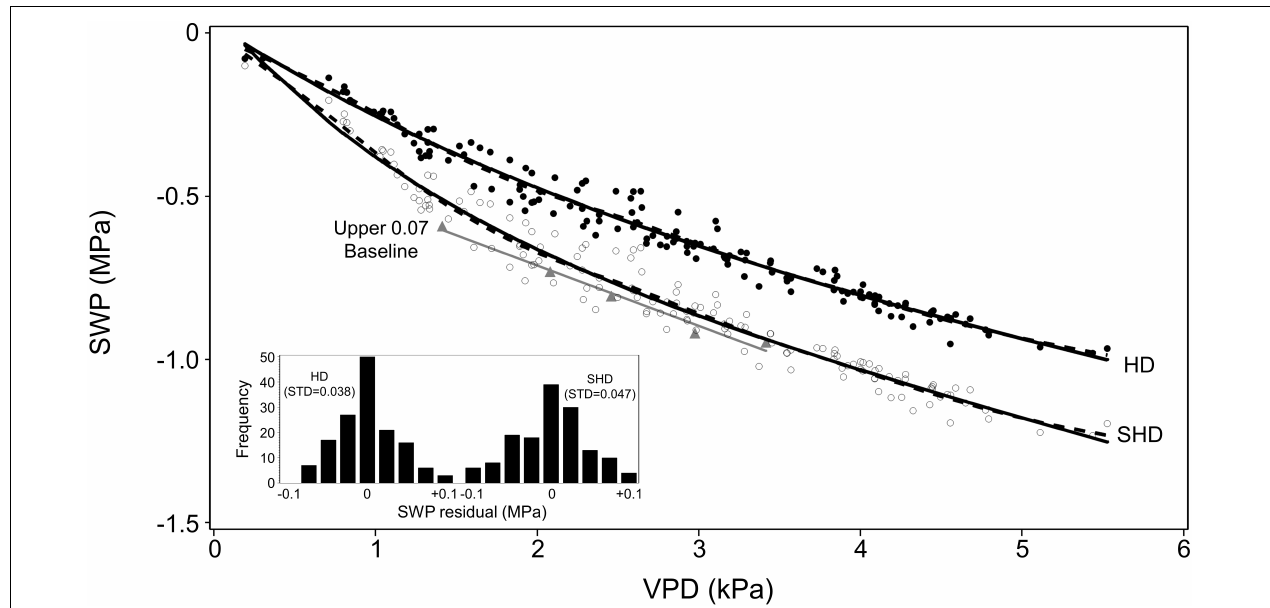
FIGURE 4 | Relation of SWP to midday VPD modeled by García-Tejera et al. (2021) for high density (HD, filled circle) and super-high density (SHD, empty circle) orchard conditions, as well as the same relation for the upper 0.07 fraction of SWP (filled triangles) found in the current study. The dashed lines for HD and SHD models are 50% smoothed spline functions (Proc Transreg SAS 9.4) and the solid lines are a combined linear and exponential function (see Table 2 for parameters) fit to the data. A linear fit (also shown in Figure 2 ) for the upper 0.07 fraction is shown for reference. Inset shows the distribution and standard deviation (STD) of the residuals from the HD and SHD points to the combined linear/exponential fit. Both distributions were normal.